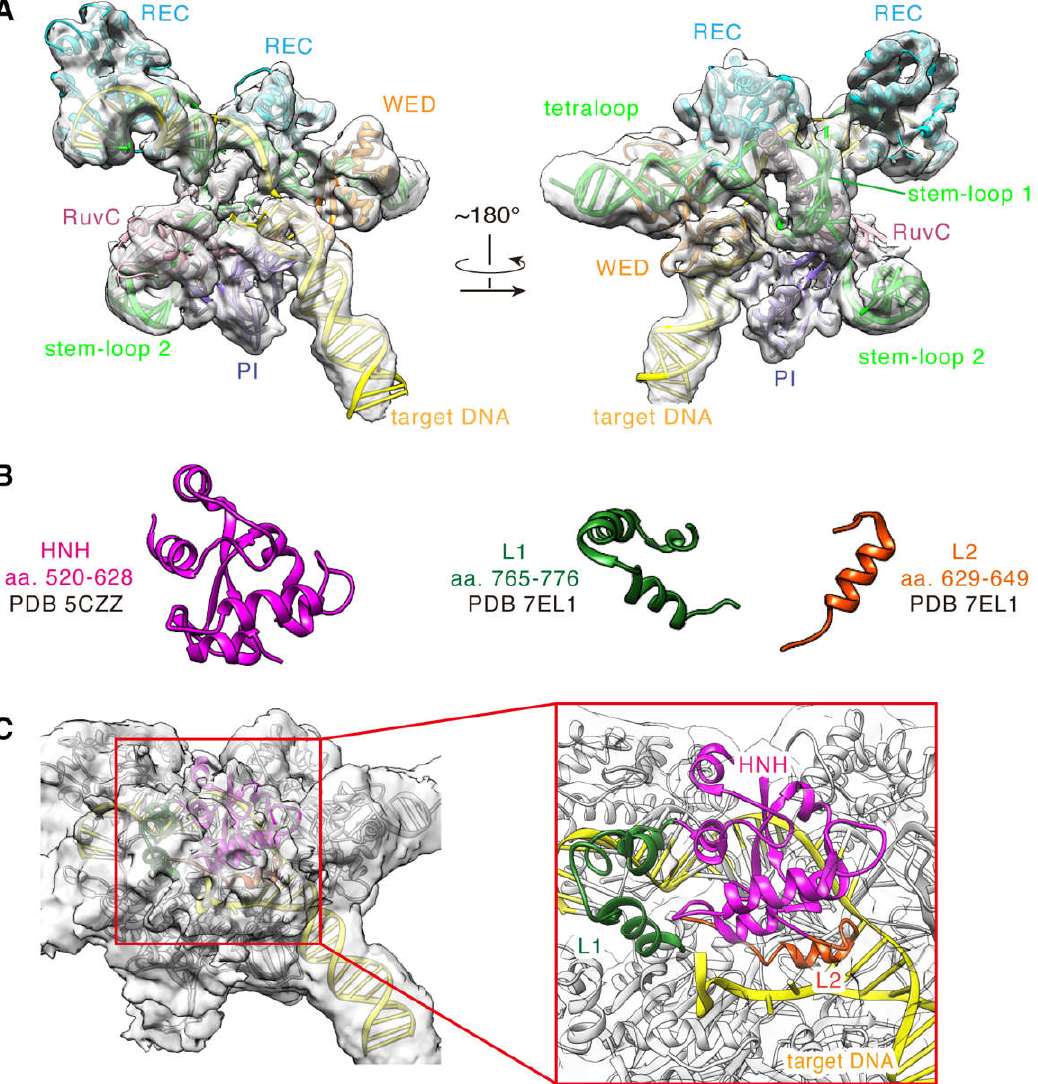
Figure 4. Cryo-EM structure of SaCas9-sgRNA-DNA ternary complex. ( A ) The EM-based structure with its cryo-EM density map (contour level= ~0.0047). ( B ) The conformation of the reference structure for HNH (pink), L1 (dark green), and L2 (orange) domains. ( C ) The HNH/L1/L2 domain model with its cryo-EM density map (contour level = ~0.0022). The HNH, L1, and L2 domains are represented by cartoons in pink, dark green, and orange,